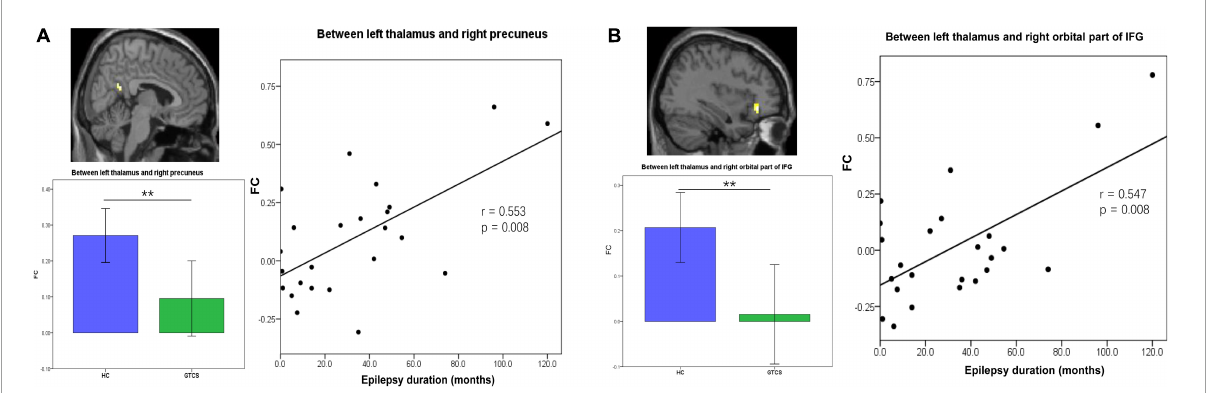
FIGURE4 Partial correlation between static FC and the epilepsy duration in children with GTCS. (A) The FC values between the left thalamus and right precuneus showed a significant correlation with the epilepsy duration ( r = 0.553, p = 0.008). (B) The FC values between the left thalamus and right orbital part of IFG showed a significant correlation with the epilepsy duration ( r = 0.547, p = 0.008). FC, functional connectivity; IFG, inferior frontal